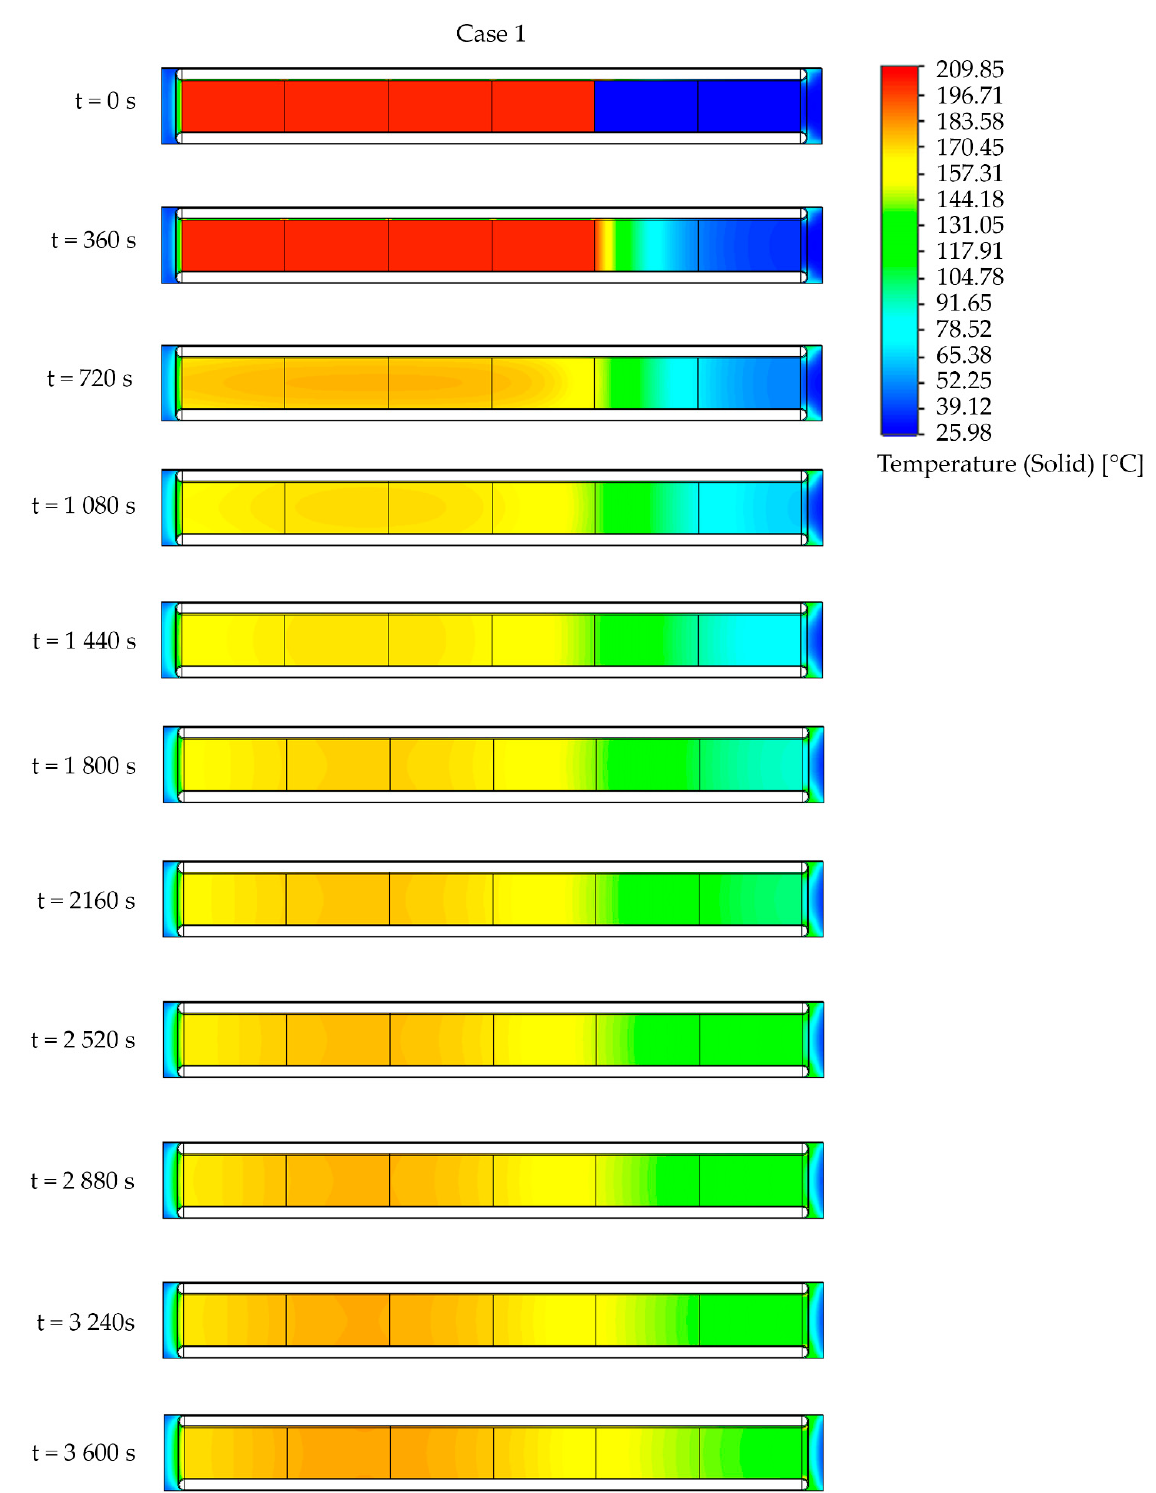
Figure 12. Temperature field in the longitudinal section view of heat accumulator in process of charging in Case 1.